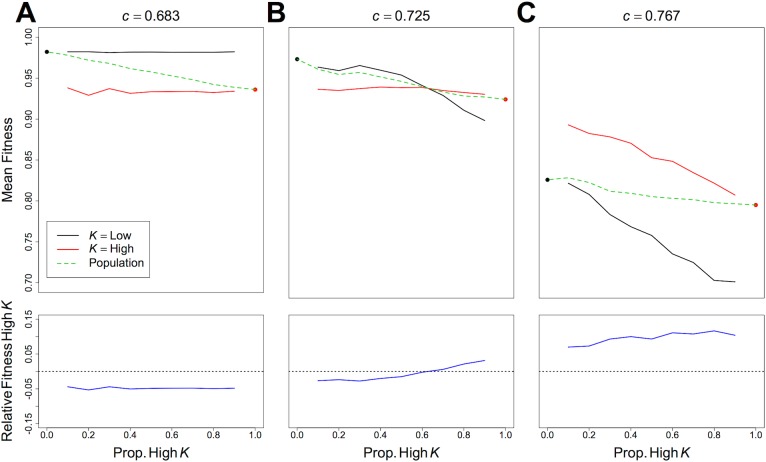
The Effects of the Proportion of the population With High K on Fitness at the End of a Single Generation.The effects of the proportion of the population with high K (K = 0.85) on the fitness of mean fitness of low K individuals (K = 0.25; black lines), high K individuals (red lines), the whole population (dashed green lines), and the relative fitness of high K individuals (fitness of high K—fitness of low K; blue line lower panels) at the end of a generation, under A) c (Equation 3) = 0.683, B) c = 0.725 and C) c = 0.767.